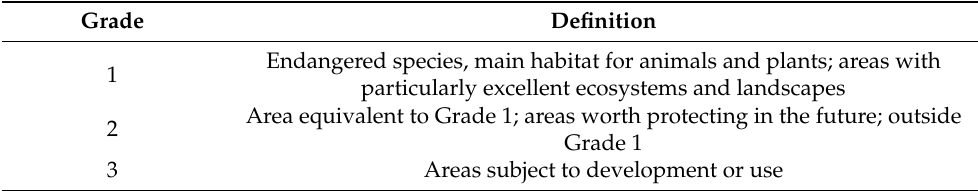
Table 5. Definitions of the ecological natural map grades [48]. Grade Definition Endangered species, main habitat for animals and plants; areas with particularly excellent ecosystems and